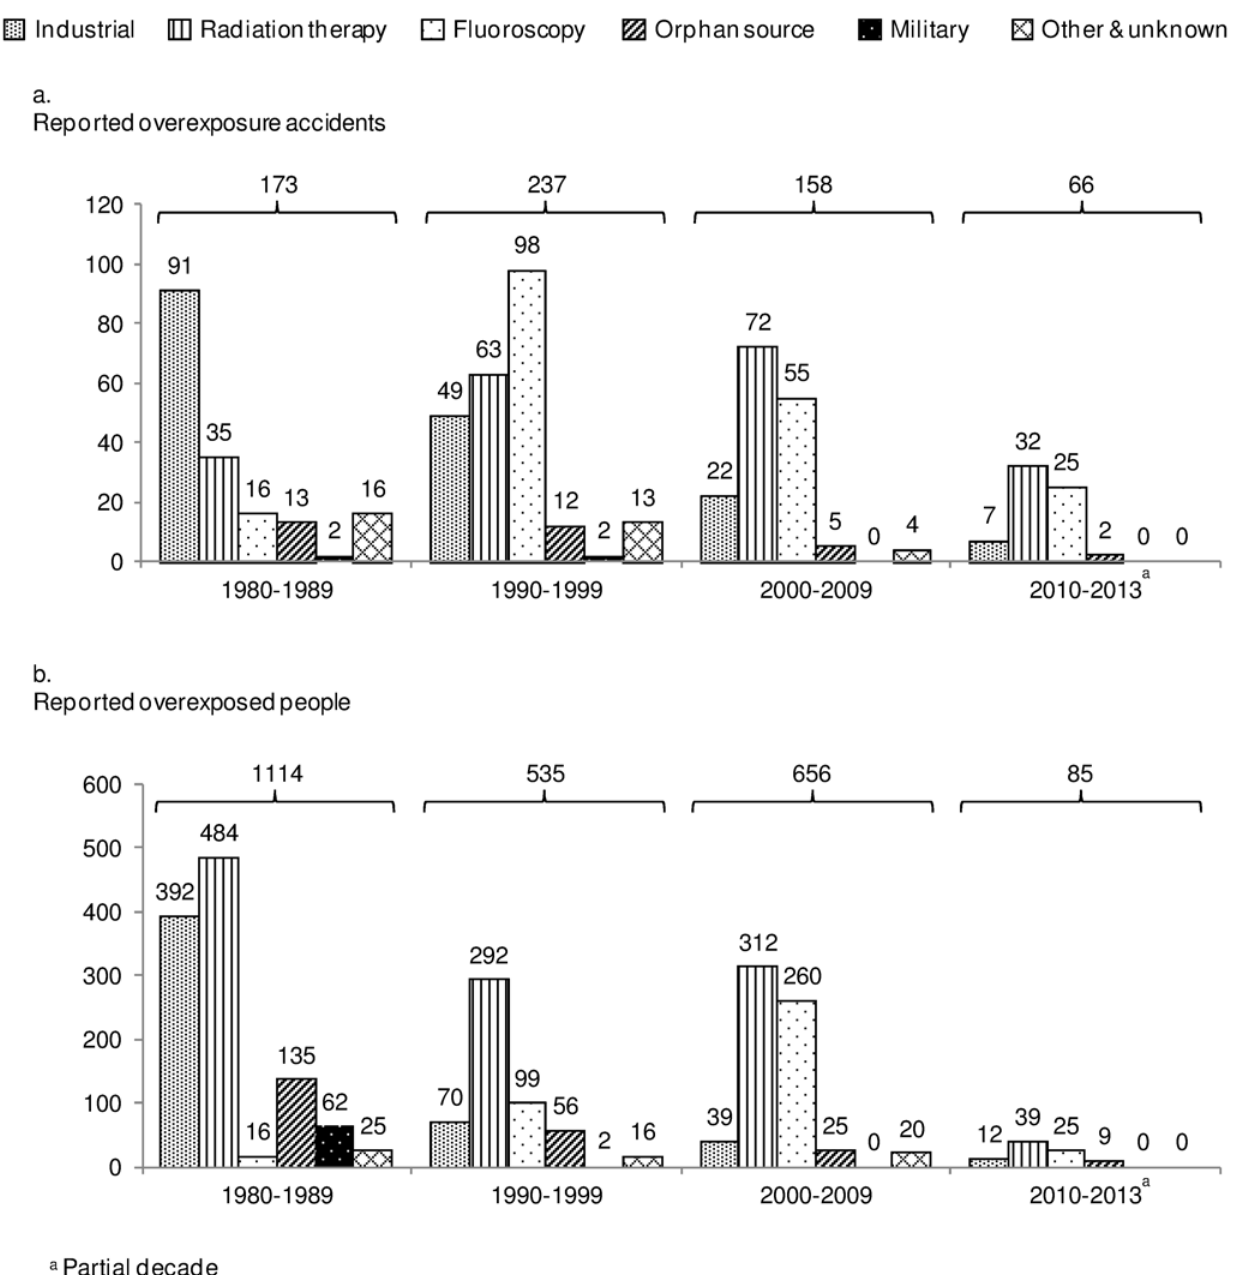
Fig 2. Reported radiation overexposure accidents worldwide and sector involved, 1980 – 2013. (a) number of reported radiation accidents (b) number of reported overexposed people. a Partial